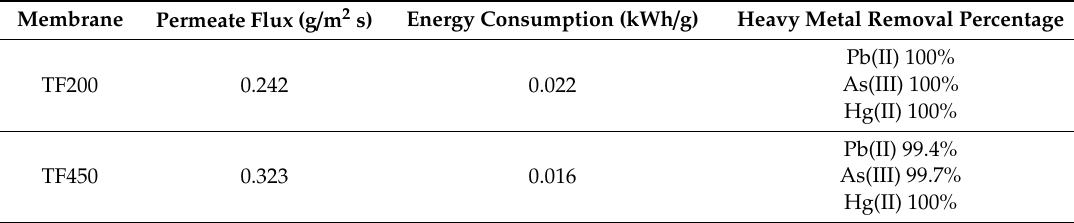
Table 3. Permeate flux, energy consumption and rejection factor for synthetic wastewater via TF200 and